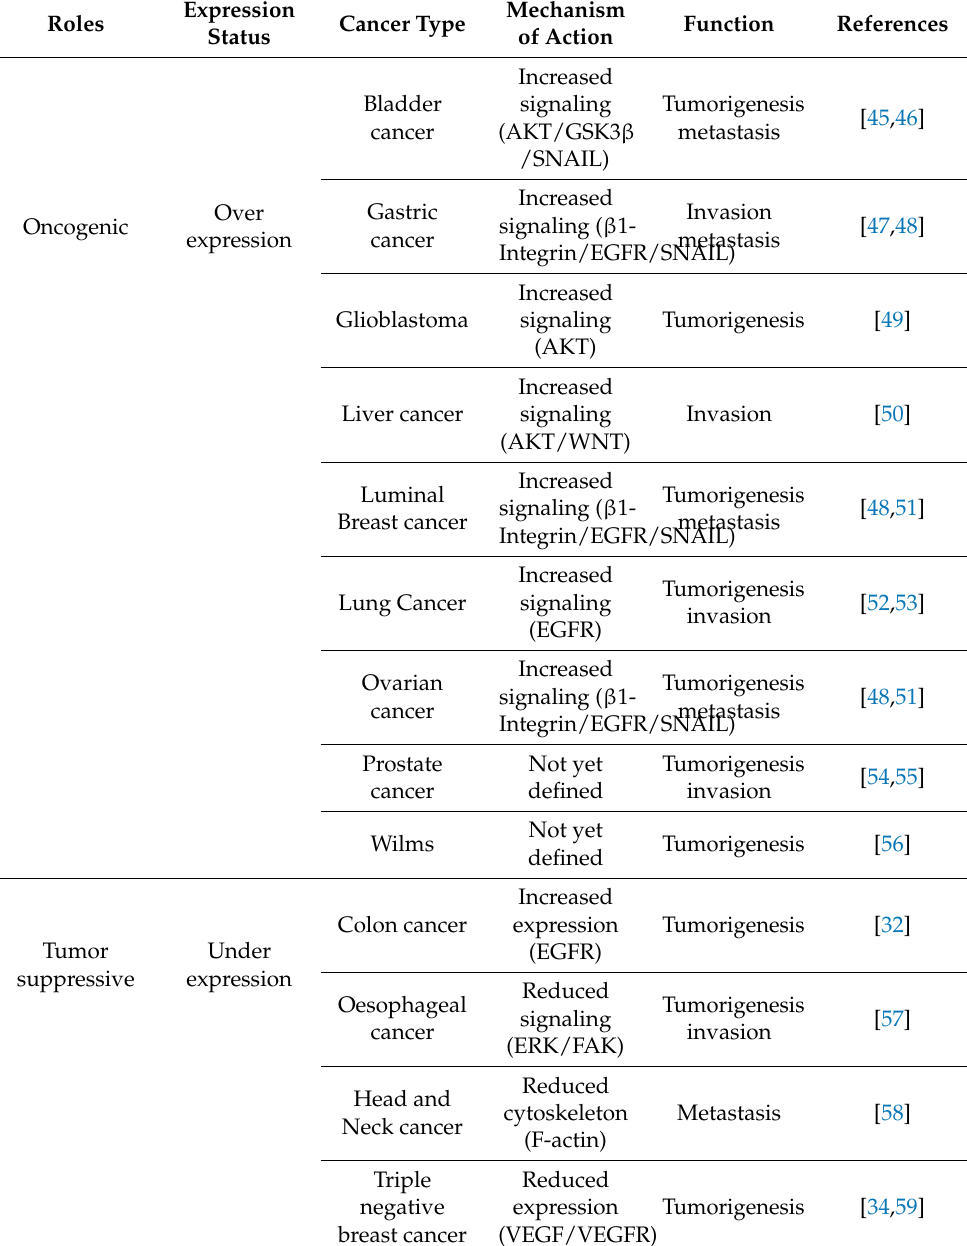
Table 4. Roles of RAB25 in cancer (adapted from